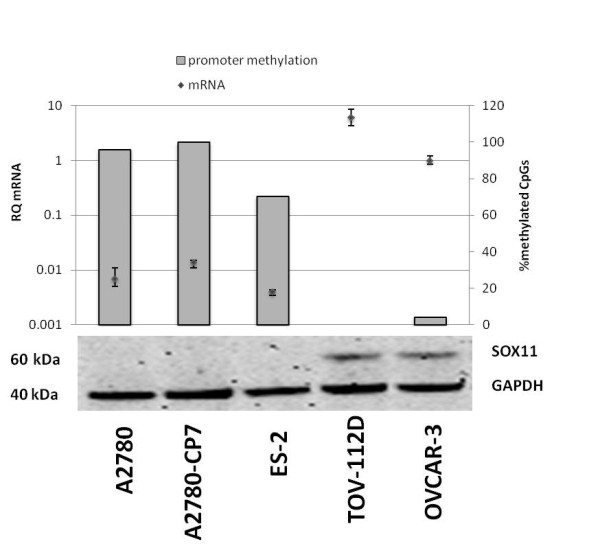
Promoter methylation of SOX11 correlates to mRNA and protein expression in EOC cell lines. The relative mRNA levels (RQ) as compared to OVCAR-3 are shown as diamonds. The standard deviation for the RQ values has been calculated with a 95% confidence interval (CI). Below, corresponding protein levels are shown. The degree of SOX11 promoter methylation, described as percentage of methylated CpGs of 28 possible CpG methylation sites, is shown as bars. The three cell lines A2780, A2780-CP7 and ES-2 all lack mRNA and protein expression of SOX11, correlating to a high percentage of methylated CpG sites.